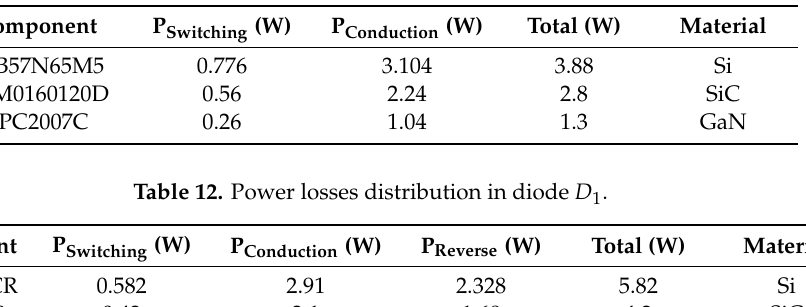
Table 11. Power losses distribution in MOSFET M 1 .